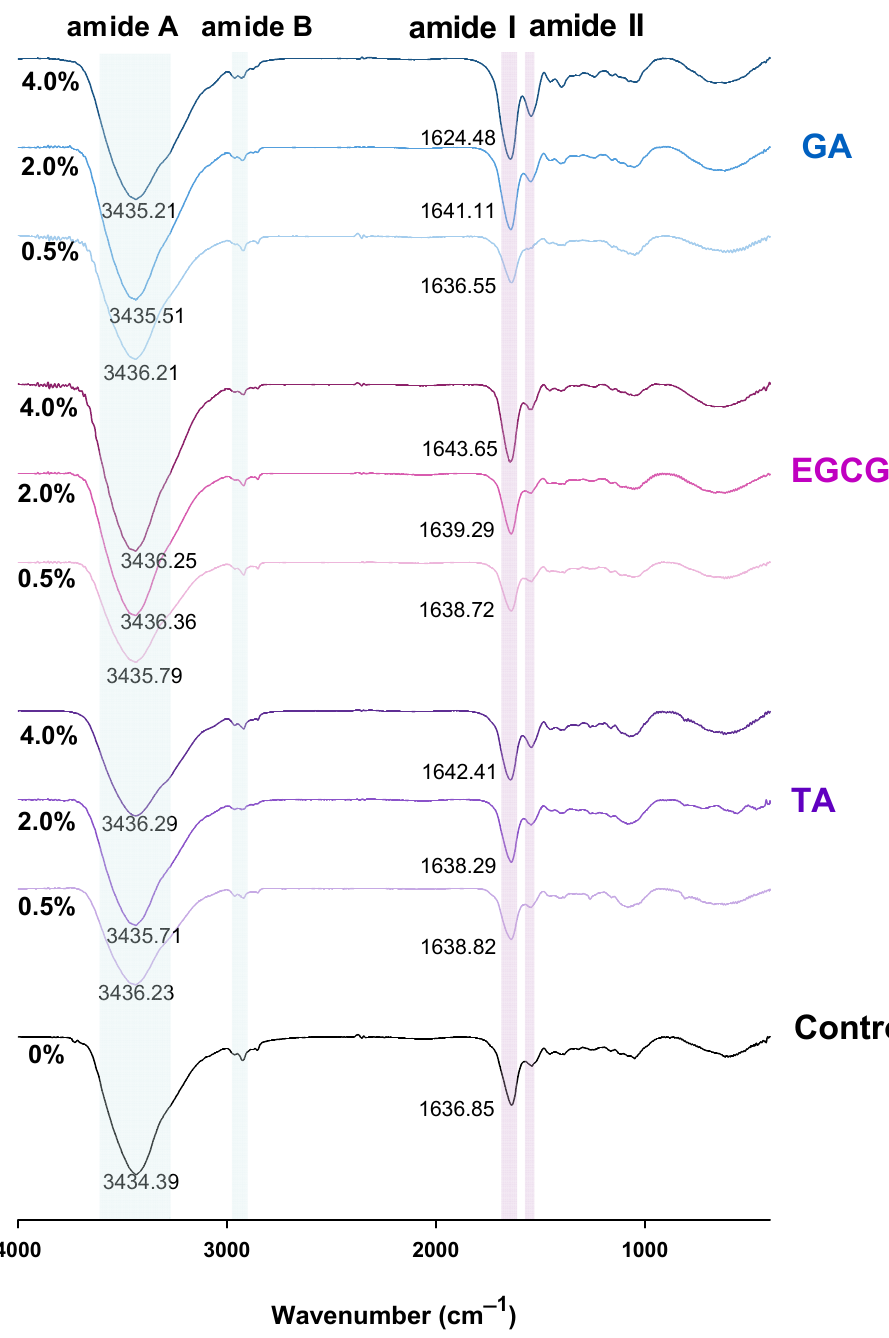
Figure 8. Fourier transform infrared spectrum of the phenolic acid-modified ginkgo seed protein gels at different concentrations (0, 0.5, 2.0, 4.0%, w/w ) of gallic acid (GA), epigallocatechin gallate (EGCG), and tannic acid